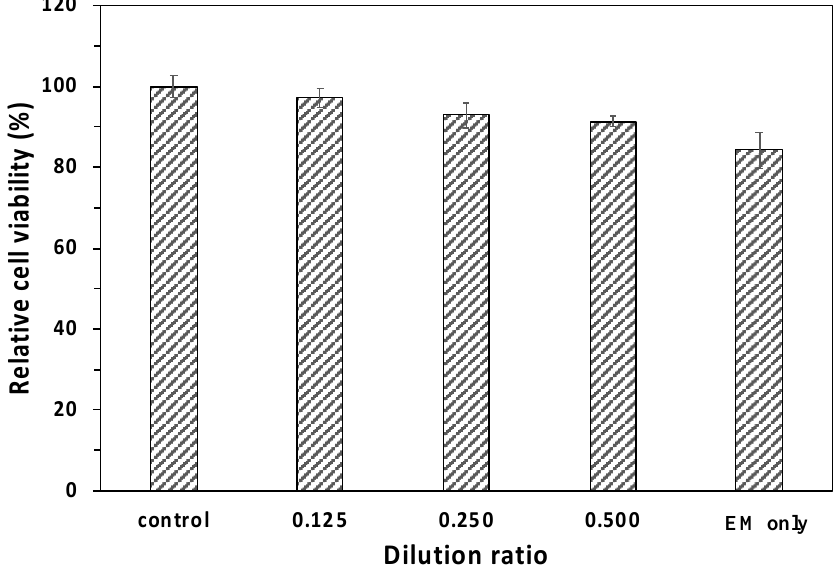
Figure 5. L929 Cell viability incubated by the extraction mediums (EM), taken from supernatants which was incubated with the model hydrogels for 24 h, at di ff erent dilute ratios according to the guidelines of ISO 10993-5. The relative L929 viability (%) of the group with a dilution ratio of 0.5 exceeded that of the group of EM only. The results of MTT assay for L929 Cell viability showed that the model hydrogels were biocompatible biomaterials (data are mean ± SD, n =